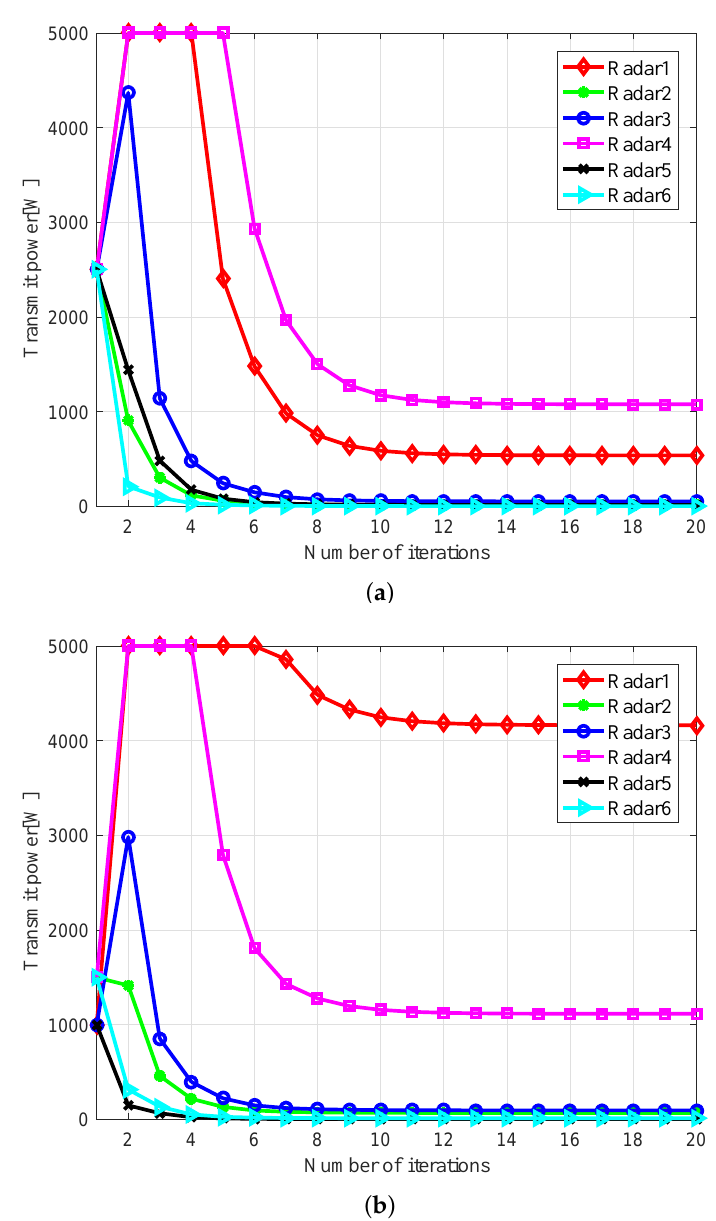
Figure 3. Convergence behavior for the transmit power of each radar in the second case: ( a ) Target position is [ 0,0 ] km; ( b ) Target position is [ − 30, − 40 ]